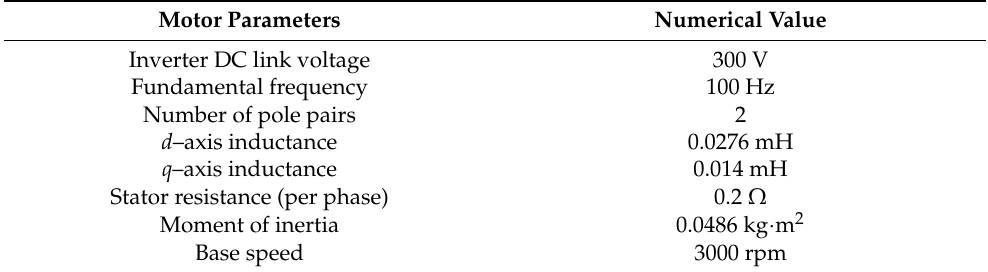
Table 4. Motor parameter table.